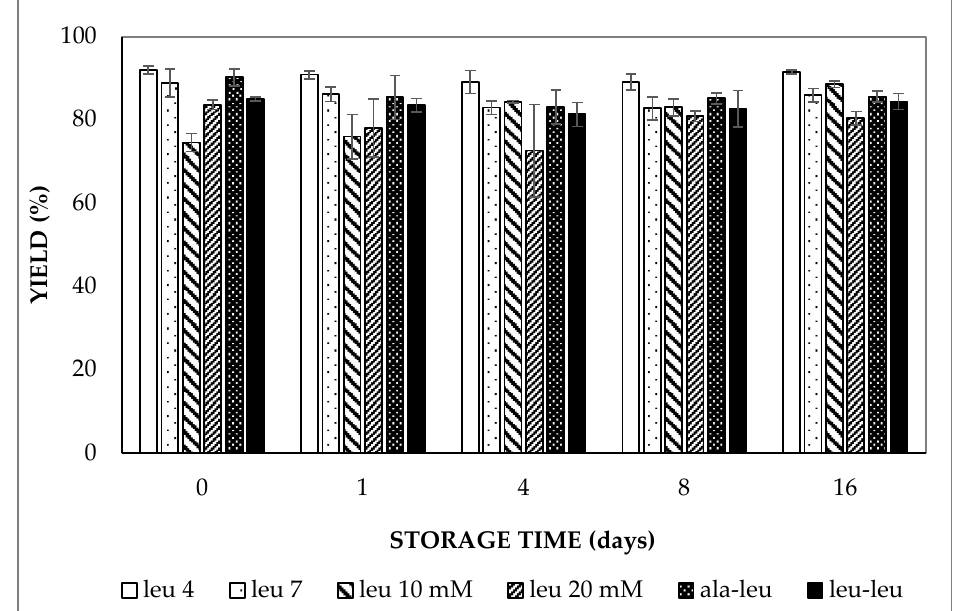
Figure 2. Yield of entrapped water in double emulsions containing either 5 mmol/L (at pH 4.0 or pH 7.0), 10 mmol/L or 20 mmol/L L-leucine, 5 mmol/L alanine–leucine or 5 mmol/L leucine–leucine (all at pH 7) prepared with HOSO upon storage at 37 °C.